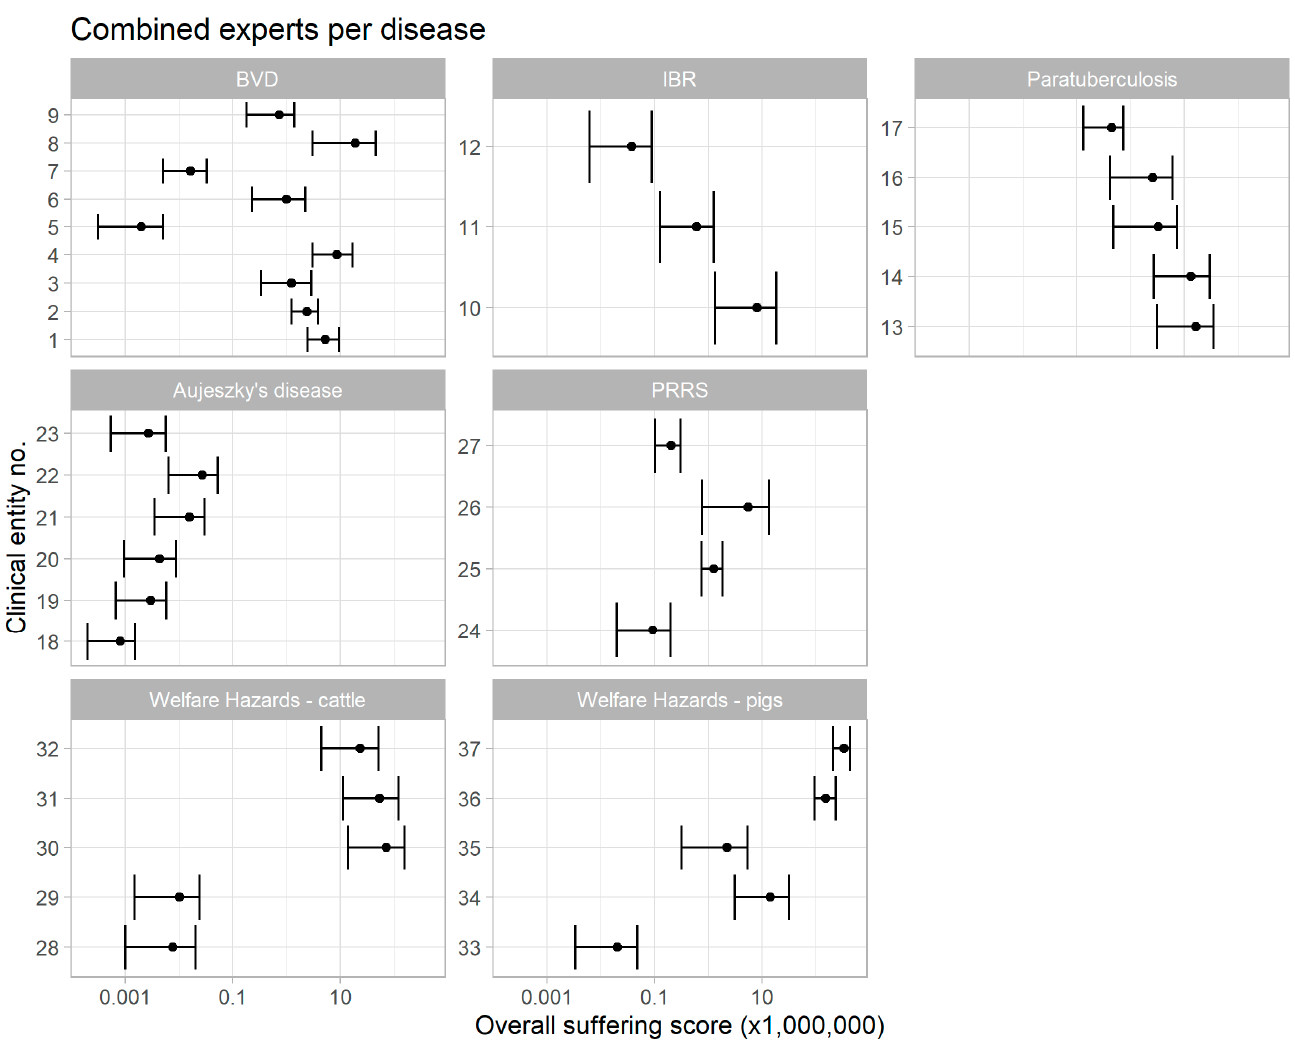
Figure 2. Aggregated suffering scores (2.5, 50, and 97.5 percentiles) by disease condition. The disease entities and welfare